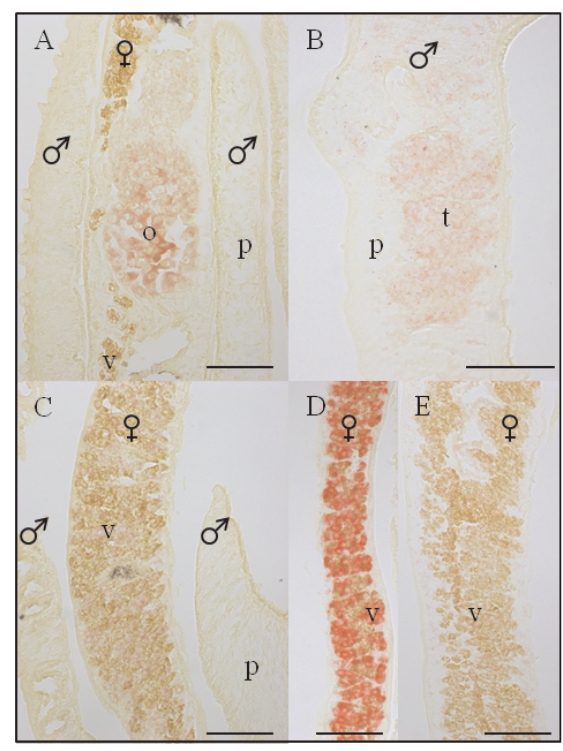
Fig. 3 – In situ hybridization with PKG-specific antisense probes. Pictures are representative for the three different probes as described in materials and methods as well as for the detection of sense transcripts. DetectionofSmcGK1transcriptin A ,ovary(o), B ,testes(t), C ,weakly within the vitellarium (v); D , p14 positive control, E , p14 negative control. (scale bar: 50 μ m; p: